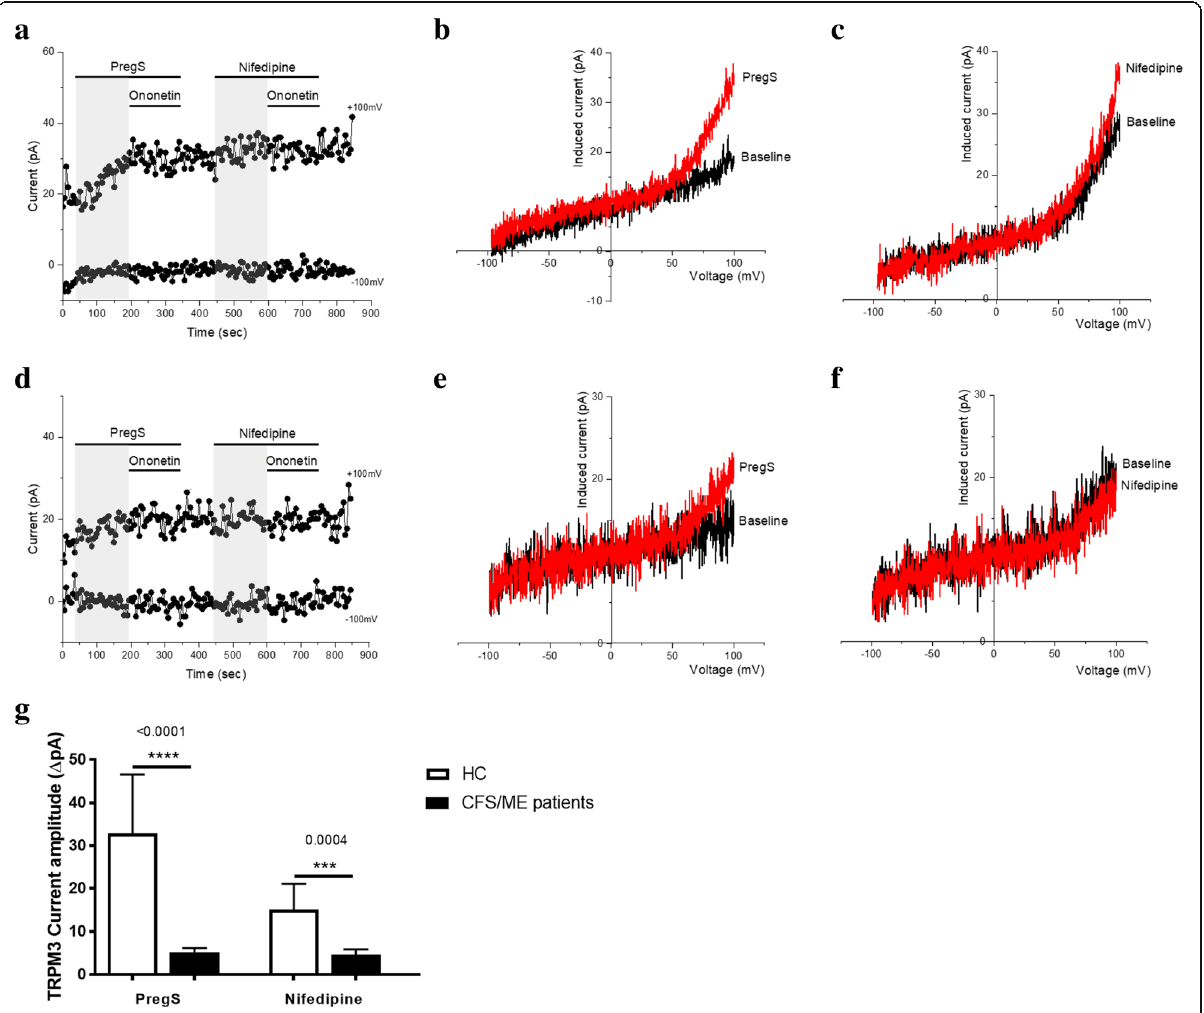
Fig. 2 TRPM3 activity after successive applications of PregS and nifedipine. Data were obtained under whole-cell patch clamp conditions. a. A representative time-series of current amplitude at + 100 mV and − 100 mV showing the effect of 100 μΜ PregS and 100 μ M nifedipine on ionic currents in isolated NK cells from HC. b. I – V before and after PregS stimulation in a cell corresponding with ( a .) . c. I – V before and after nifedipine stimulation in a cell corresponding with ( a .) . d. A representative time-series of current amplitude at + 100 mV and − 100 mV showing the effect of 100 μΜ PregS and 100 μ M nifedipine on ionic currents in isolated NK cells from CFS/ME patients. e. I – V before and after PregS stimulation in a cell as shown in ( d .) . f. I – V before and after nifedipine stimulation in a cell as shown in ( d .) . g. Bar graphs representing TRPM3 current amplitude at + 100 mV after stimulation with 100 μΜ PregS and 100 μ M nifedipine in CFS/ME patients ( N = 6 ; n = 24) compared with HC (N = 6; n = 18). Data are represented as mean ± SEM. Abbreviations: CFS/ME, chronic fatigue syndrome/myalgic encephalomyelitis; HC, healthy controls; NK, natural killer; PregS, Pregnenolone sulfate; TRPM3, Transient Receptor Potential Melastatin